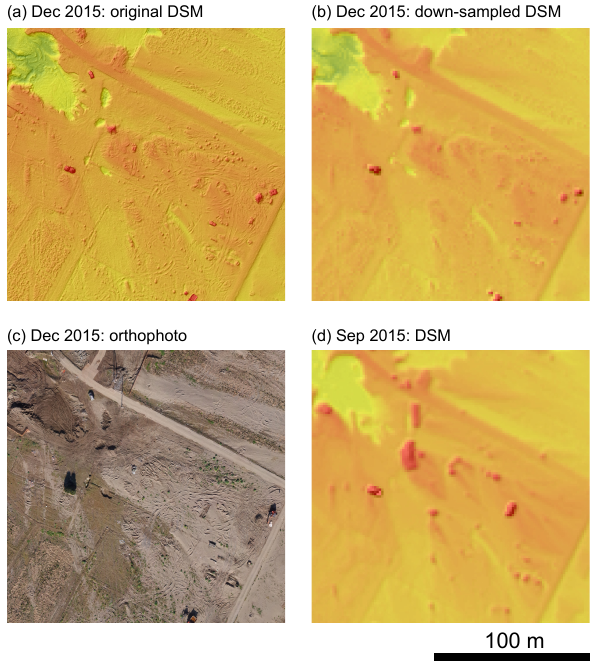
Figure 5. Enlarged views of Fig. 3 images for comparison of the DSMs with different resolutions. (a) Original DSM for December 2015 (resolution: 3.84 cm). (b) Down-sampled DSM for December 2015 (resolution: 1m). (c) Orthophoto taken in December 2015. (d) DSM for September 2015 (resolution: 1m). Note that the trivial relief in (a) is largely removed in the down-sampled DSM in (b)